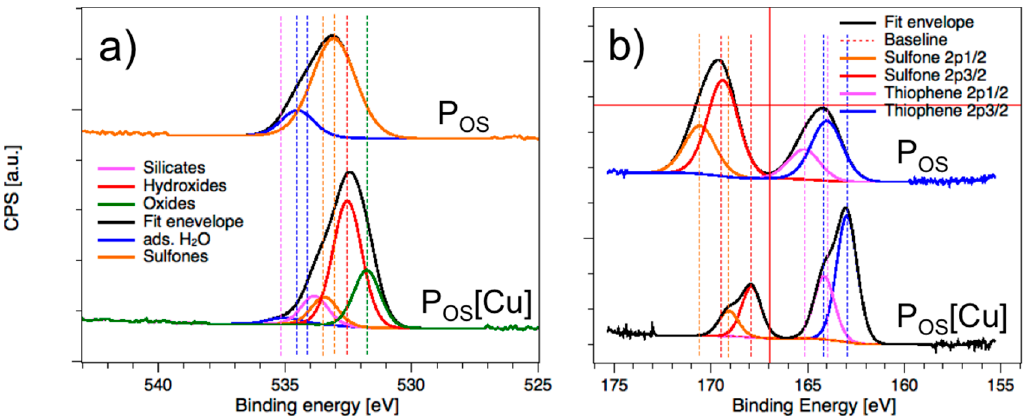
Figure 3. ( a ) O(1s) and ( b ) S(2p) core-level spectra of the analyzed samples P OS (top) and P OS [Cu] (bottom) by X-ray photoelectron spectroscopy.